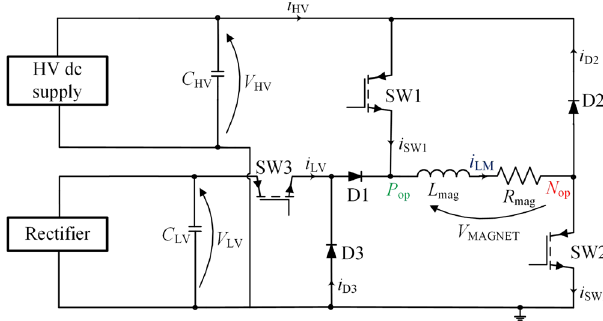
FIG. 8. Simplified electrical schematic of the UCN kicker system (described in the